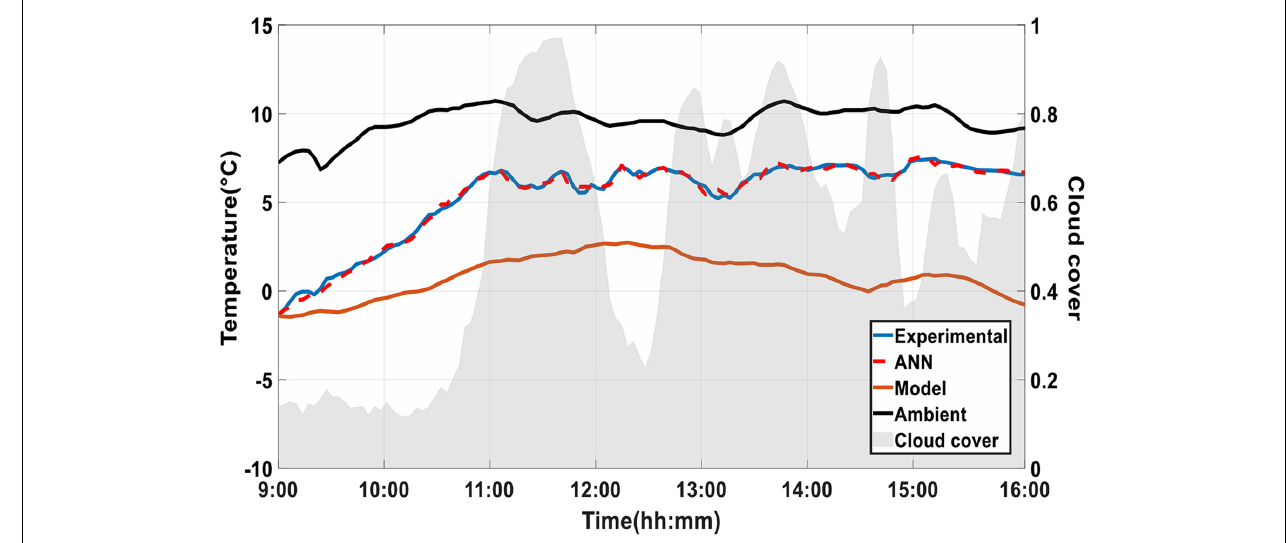
FIGURE 9 | Model and ANN result in a cloudy day (February 28,